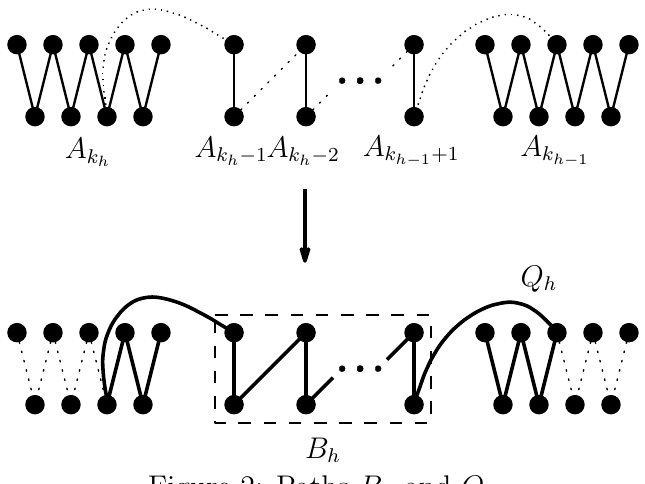
Figure 2: Paths B